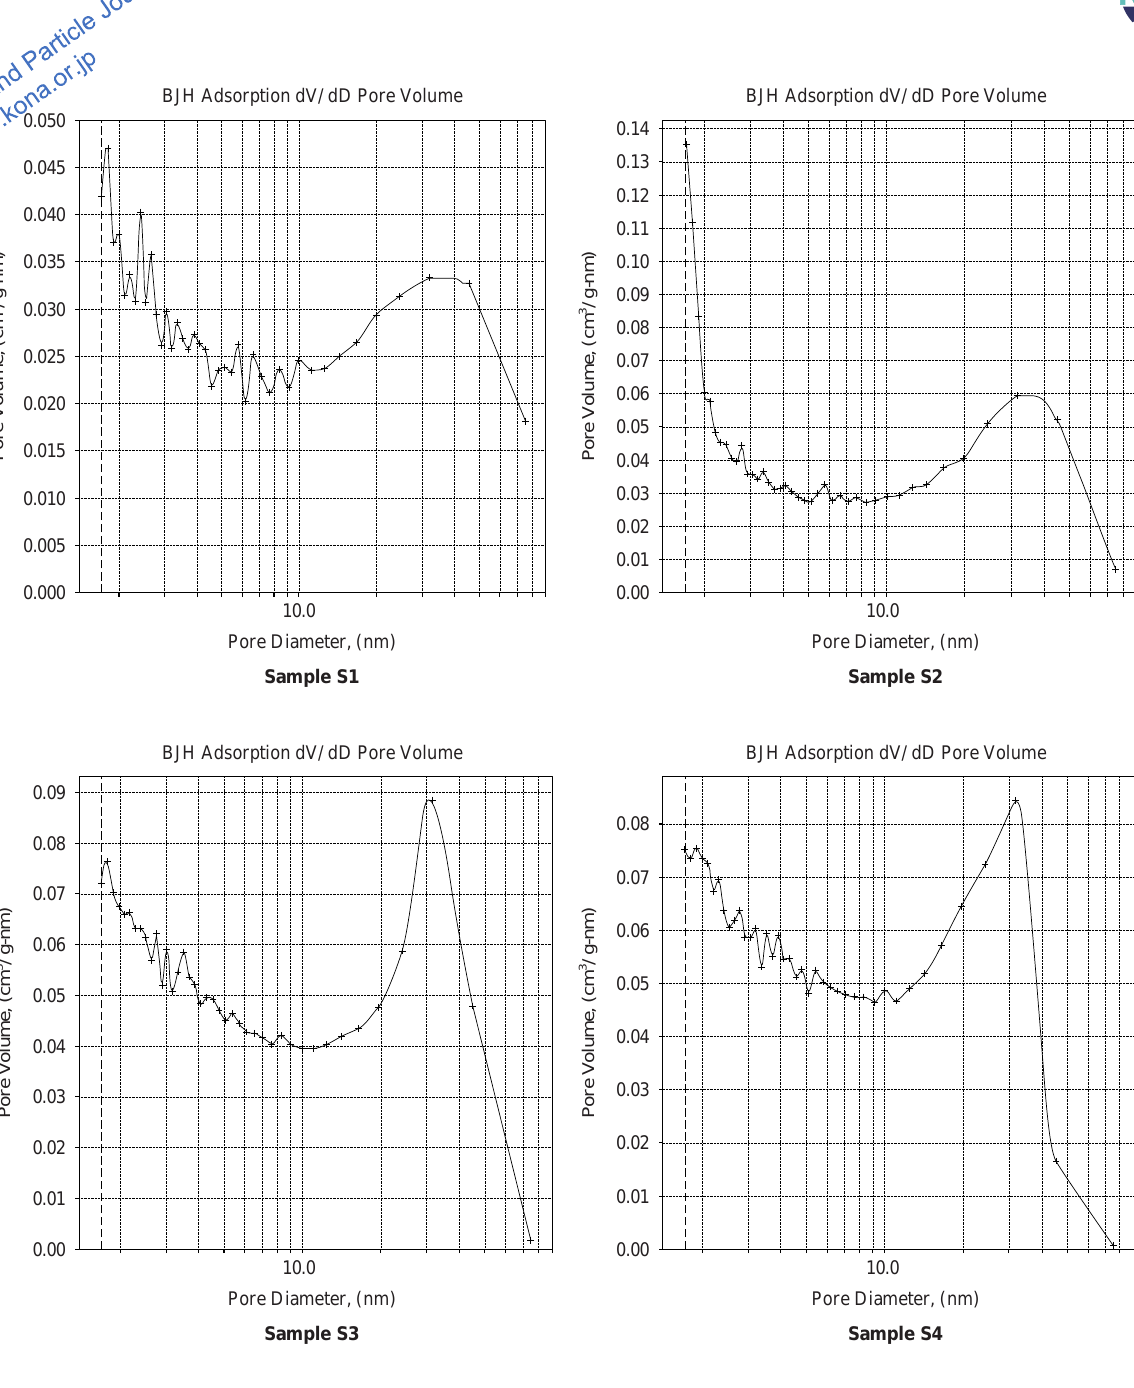
Fig. 3 Pore size distribution of aerogel samples (BJH